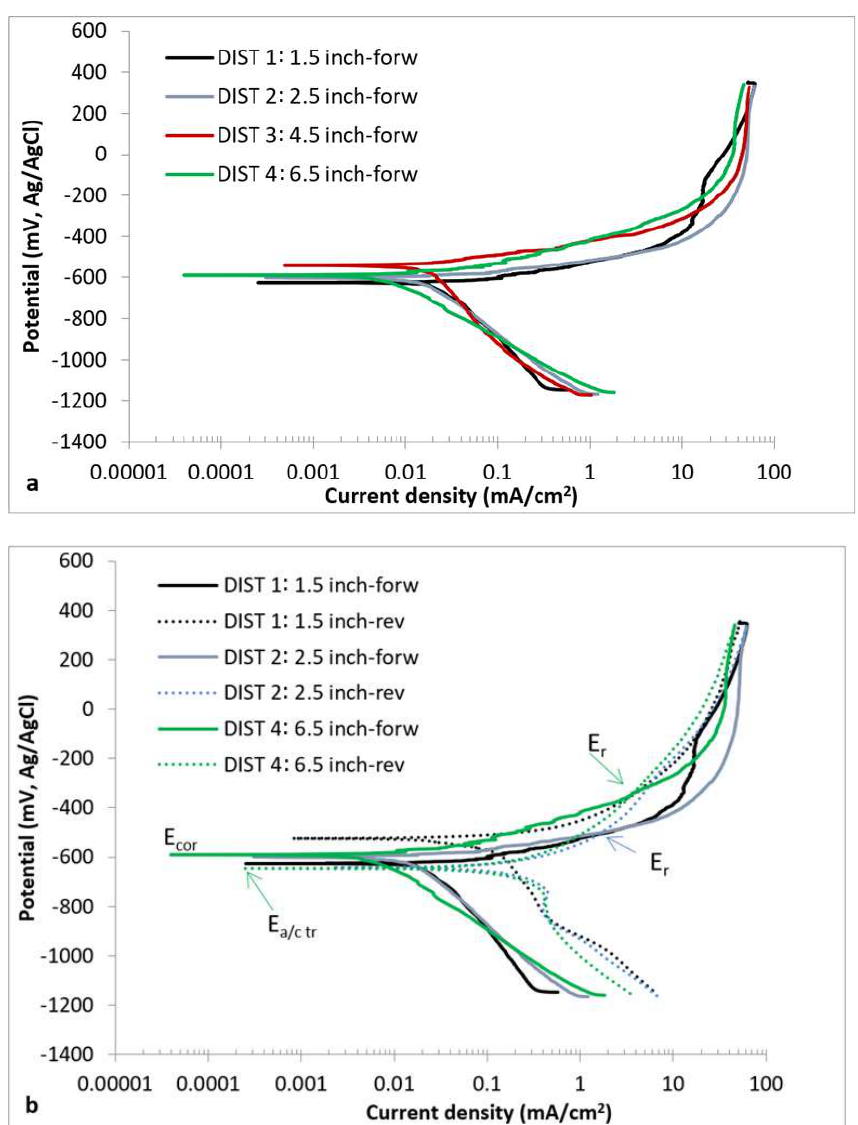
Figure 10. Effect of thermal spraying distance on the cyclic polarization behavior of nickel aluminide coatings. ( a ) Forward polarization curves; ( b ) cyclic (forward and reverse) polarization curves (3.5% NaCl, 25 °C). Table 4. Electrochemical values of the coatings immersed in 3.5% NaCl at 25 °C: Effect of spray distance.